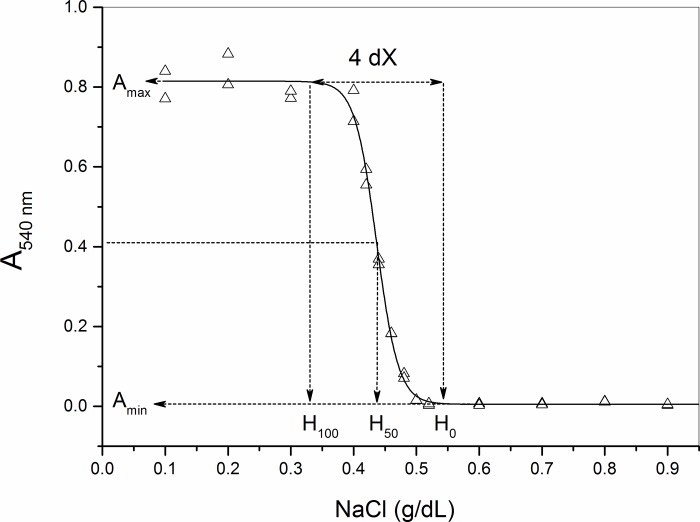
Typical curve of hyposmotic lysis of erythrocytes, with definition of the osmotic stability variables Amim, Amax, H0, H50, H100, and dX.